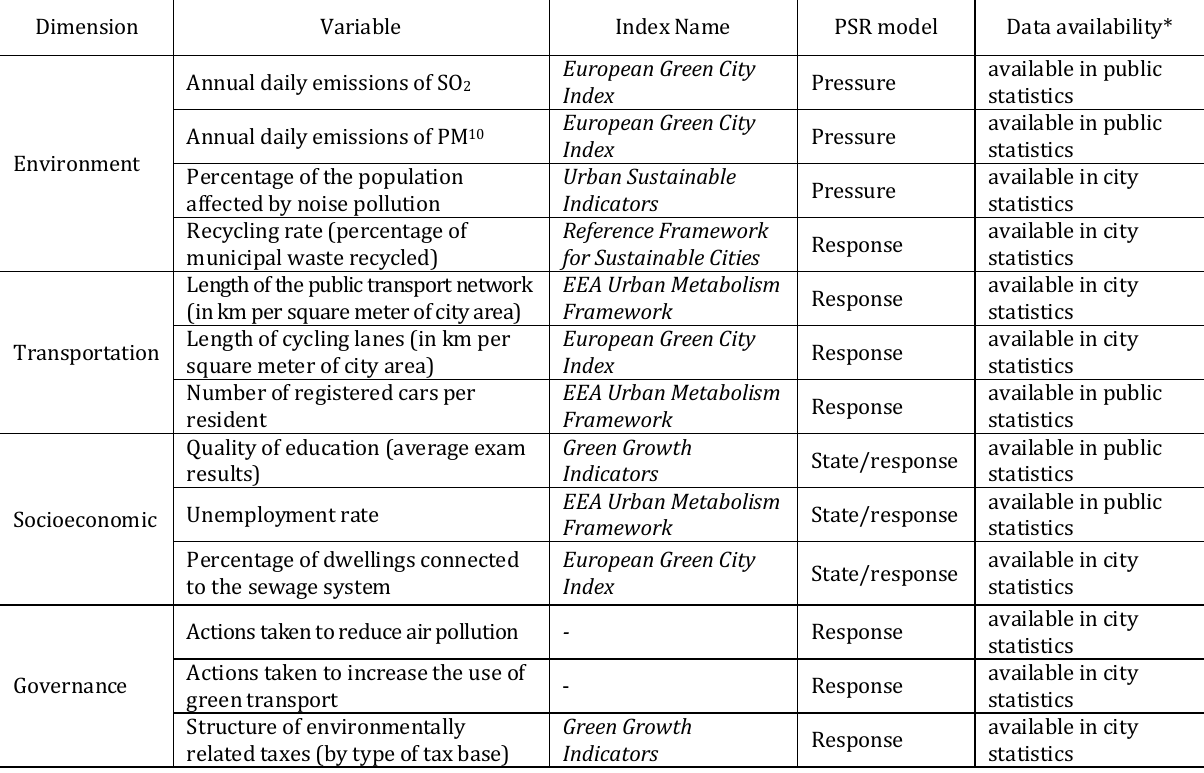
Table 3. Sustainable Development (Source: own